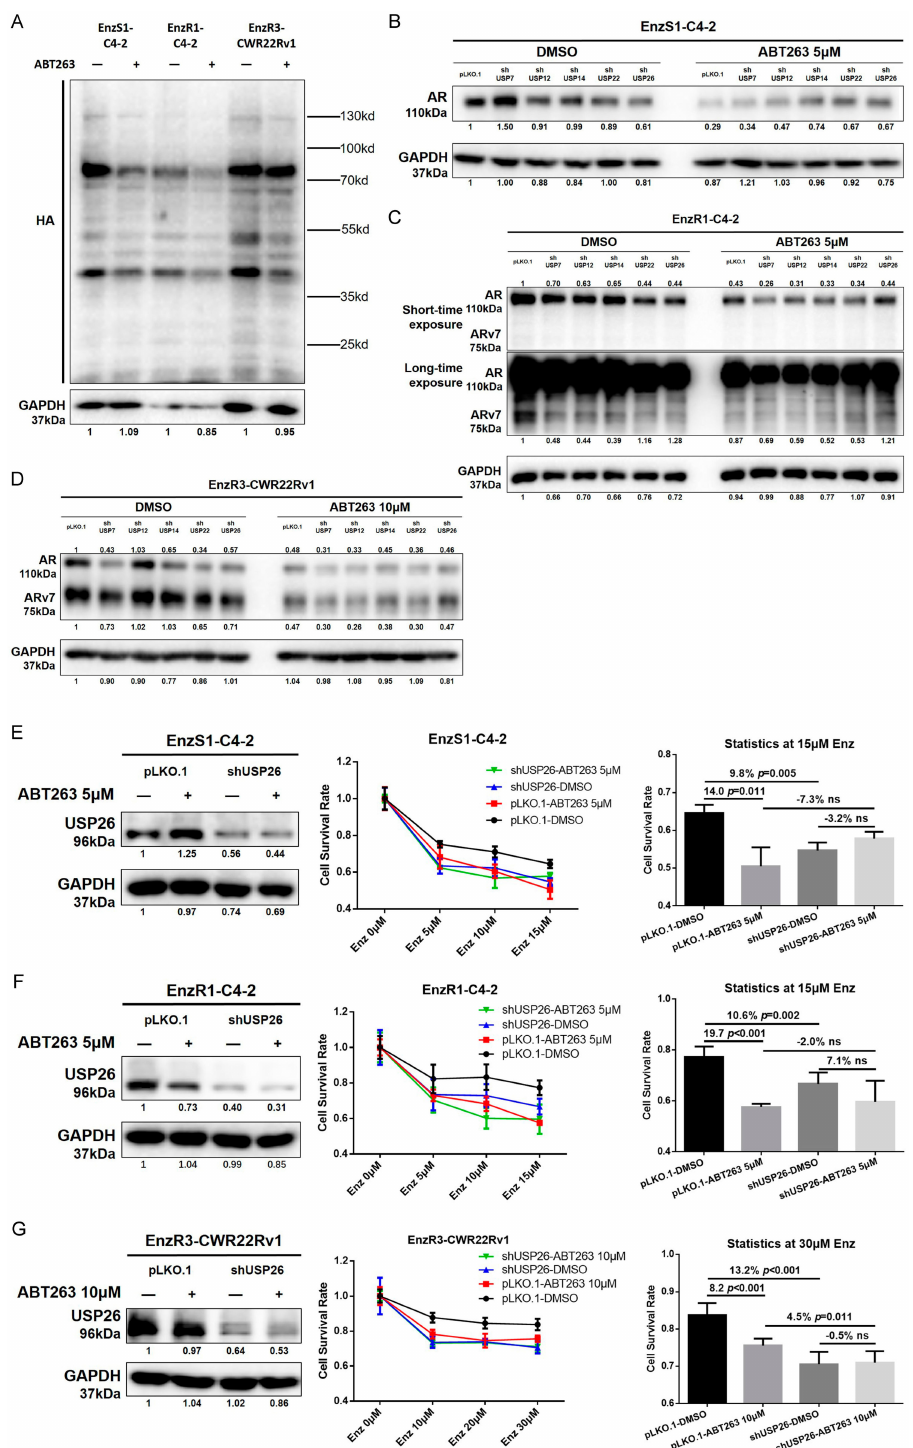
Figure 5. ABT263-induced cellular ROS inhibits USP26 activity leading to increase of Enz sensitivity in PCa cells. ( A ) ABT263 inhibits general deubiquitinating enzymes (DUB) activity. In vitro DUB activity assays and western blot assays were used to detect general DUB activity in EnzS1-C4-2, EnzR1-C4-2, and EnzR3-CWR22Rv1 cells. Active DUB protein could be distinguished from the inactive species by immunoblotting with anti-HA antibody. ( B–D ) ABT263 decreases AR and ARv7 protein expression mainly through USP26. We used lentivirus construction to knock down five ubiquitin specific protease (USP) candidates. Western blot assay was used to detect which USP, upon knock down, could not